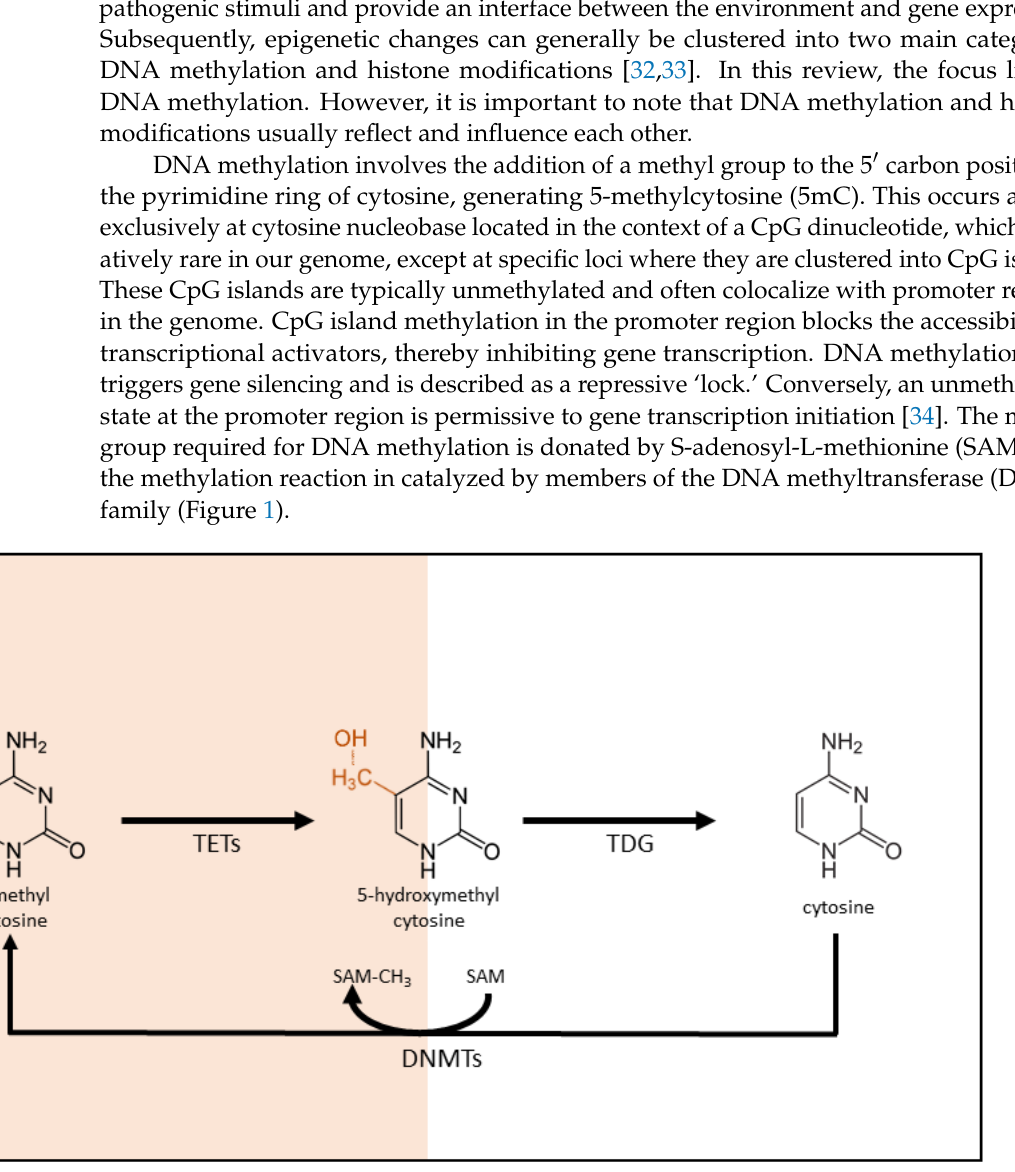
Figure 1. The DNA (de)methylation process. In DNA methylation, cytosine is converted to 5-methylcytosine by DNA methyltransferase (DNMT). Members of the DNMT family catalyze the transfer of a methyl group (CH 3 ) from S-adenosyl-L-methionine (SAM) to the 5-carbon position of cytosine. The methyl group required for DNA methylation is donated by SAM. DNA demethylation is a multistep oxidation process catalyzed by the ten-eleven translocation (TET) methylcytosine dioxygenase family.